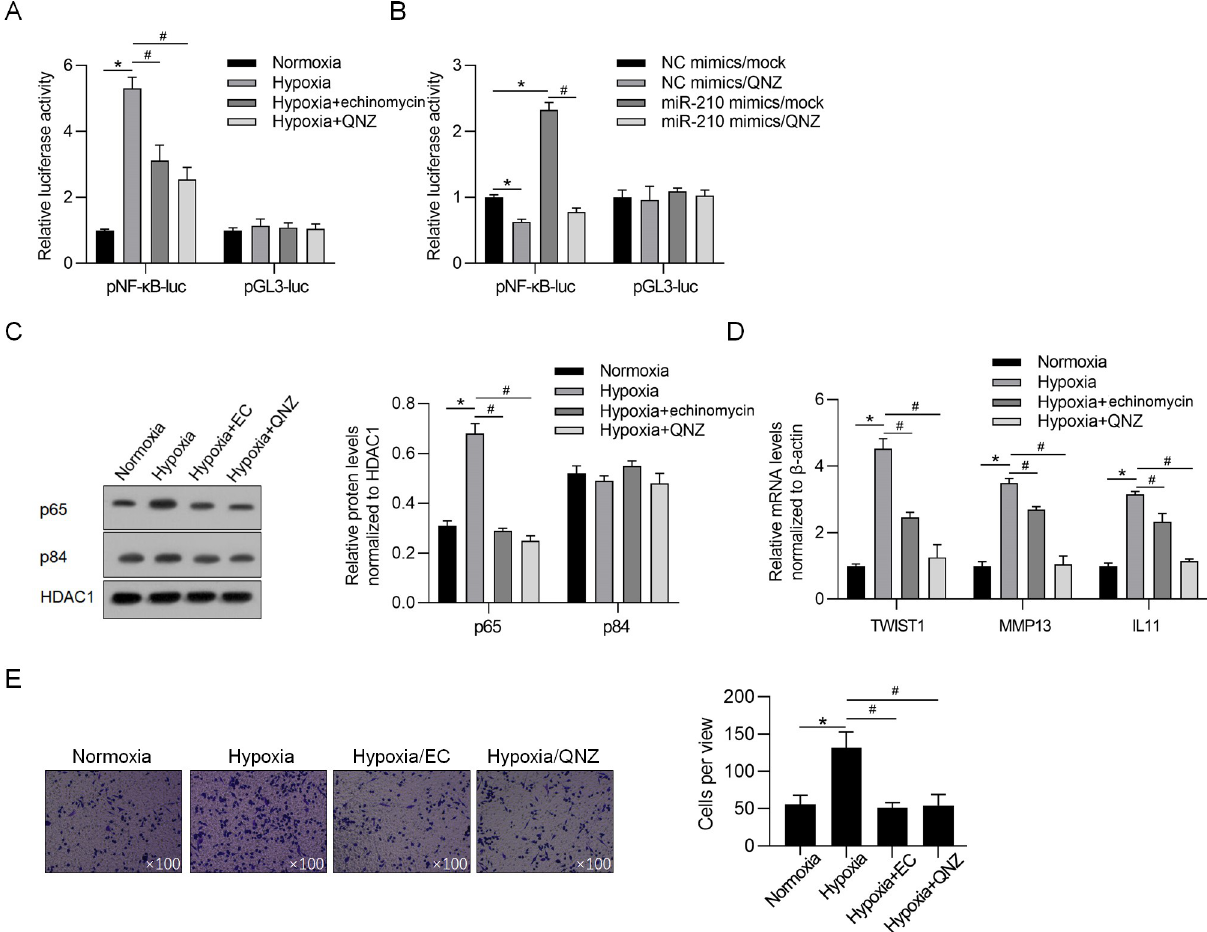
Fig 7. Hypoxia-induced miR-210 activates NF- κ B signaling pathway and promotes invasion. A. After hypoxia exposure with echinomycin or QNZ, the transcriptional activity of NF- κ B was measured by performing luciferase reporter assay. � P < 0.05, vs. Normoxia group; # P < 0.05, vs. Hypoxia group. B. After introduction of miR-210 mimics, with or without QNZ, the transcriptional activity of NF- κ B was measured by performing luciferase reporter assay. � P < 0.05, vs. NC mimics/mock group; # P < 0.05, vs. miR-210 mimics/mock group. C. Western blot was performed to detect nuclear NF- κ B/p65 expression. The nuclear p84 and HDAC1 were used as the nuclear protein markers. D. RT-qPCR analysis of TWIST1, MMP13 and IL11 was performed after hypoxia exposure with addition of echinomycin or QNZ. � P < 0.05, vs. Normoxia group; # P < 0.05, vs. Hypoxia group. E. Invasion ability was performed to detect the effect of hypoxia on invasion via activating NF- κ B signaling. � P < 0.05, vs. Normoxia group; # P < 0.05, vs. Hypoxia group.